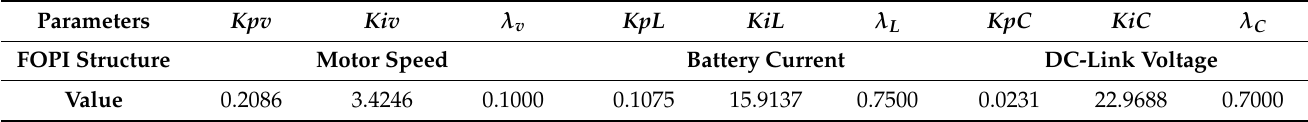
Table 3. FOPI controller parameters summary.